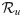
Change in Ru,Ra, Rmf and Rmm with fixed ρht = 0.9 and varying ρc and ρt.(a) Change in Ru with high ρht and varying ρc and ρt, (b) Change in Ra with high ρht and varying ρc and ρt, (c) Change in Rmf with high ρht and varying ρc and ρt, (d) Change in Rmm with high ρht and varying ρc and ρt.